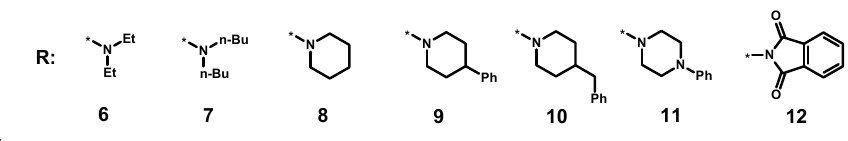
Scheme 2. Synthesis of a small library of salicylamide-Mannich base